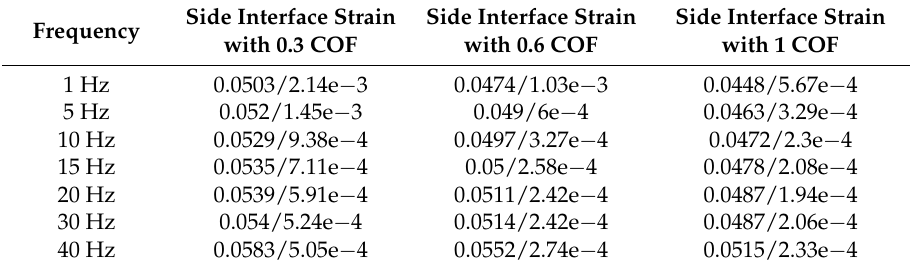
Table 3 . Maximum strain side interface values for 165 GPa (silicon)/0.0002 GPa probe at the tip.